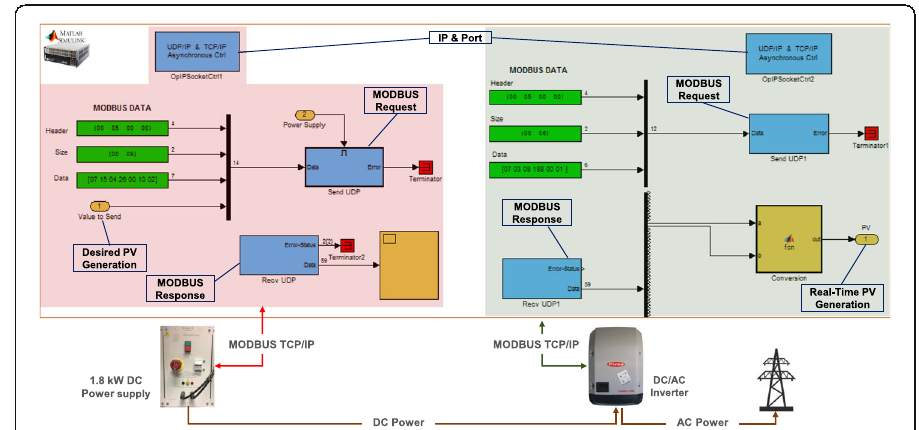
Fig. 5 Simulink HIL model for PV emulator in BUS